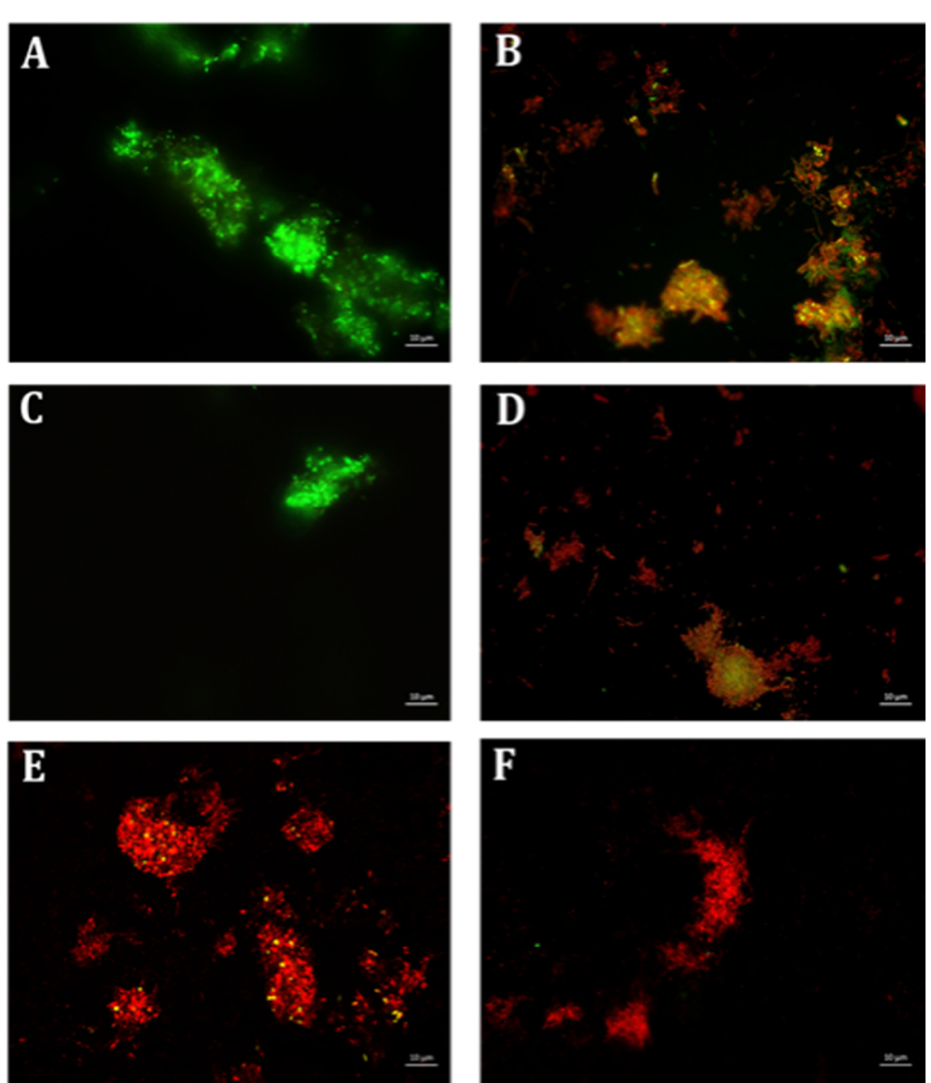
Figure 4. Fluorescence microscopic observation of cell viability on M. smegmatis biofilm formation. E: erythromycin; ES: EGCG-S. Scale bar = 10 μ m. ( A ) Control, ( B ) E15, ( C ) ES100, ( D ) ES150, ( E ) E15+ES100, and ( F ) E15+ES150. The results indicated that E15+ES150 severely affect the viability of the cells.